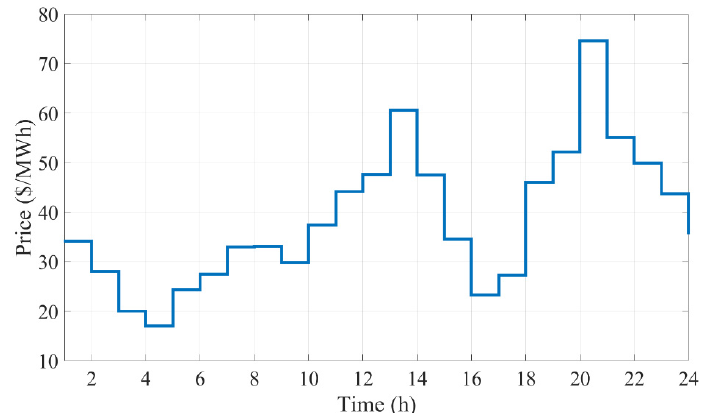
Figure 6. Estimated pool market price.